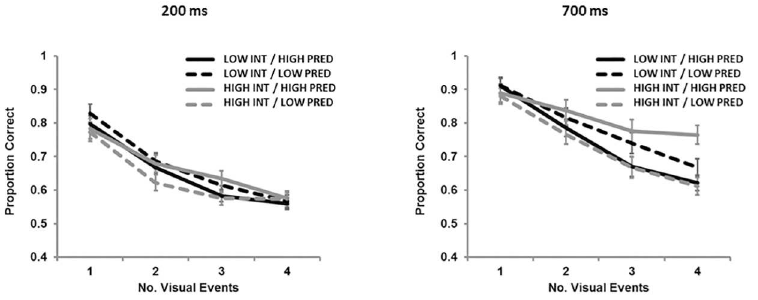
Fig 6. Proportion correct for each combination of temporal predictability, proactive interference, and number of locations changing for 200 ms SOA (left panel) and 700 ms SOA (right panel) for Experiments 1–4. Error bars indicatestandard